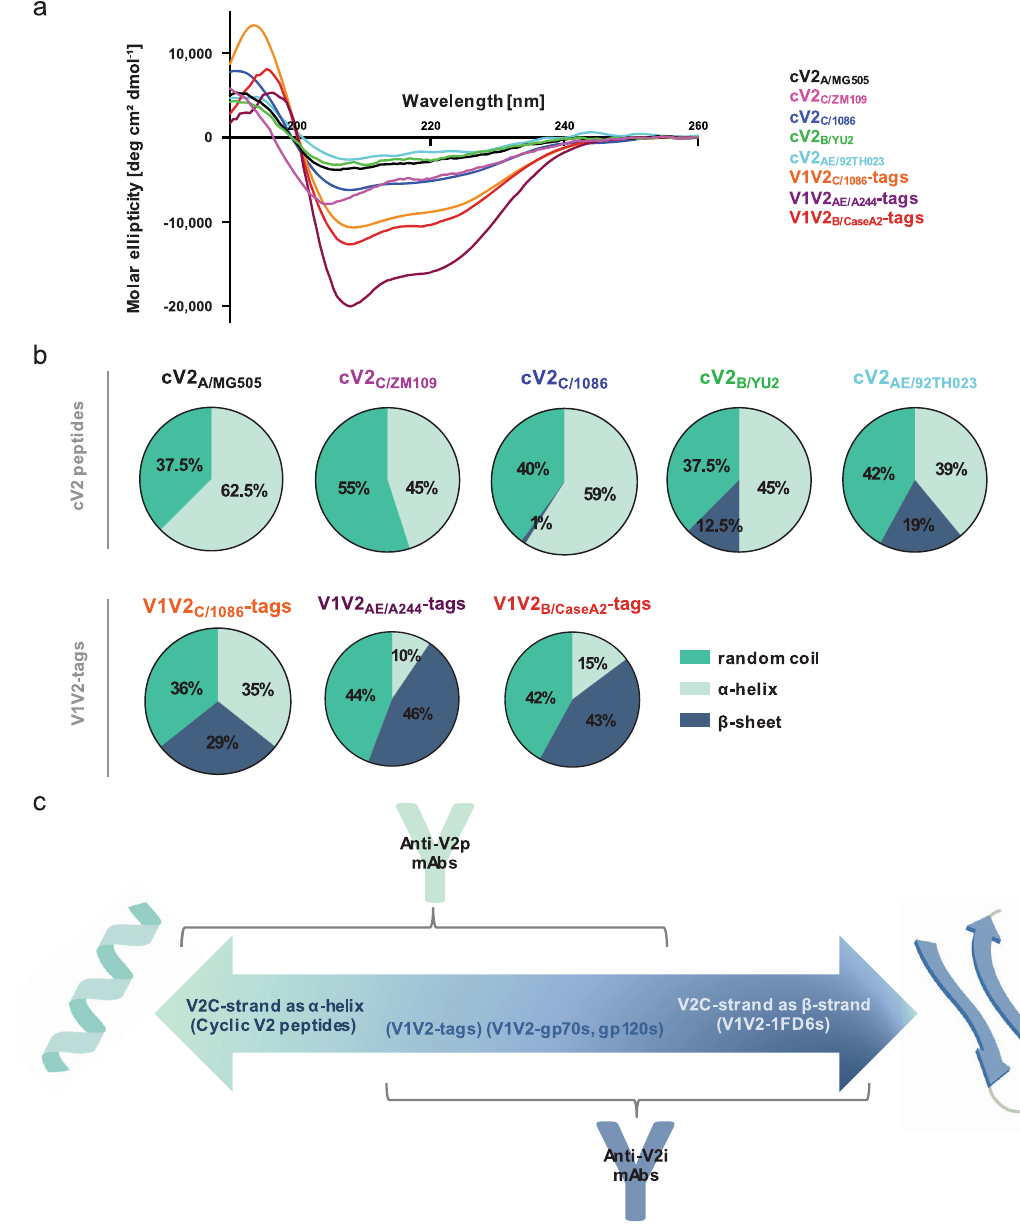
Fig. 2 Structural conformations of the V1V2 domain. a Circular dichroism spectra of fi ve cyclic V2 peptides and three V1V2-tags proteins. b Pie charts depicting the percentage of secondary structure (random coil [turquoise], α -helix [light green], or β -sheet [dark blue]) determined by the circular dichroism spectra and calculated by CD-FIT software (https://www.ruppweb.org/Xray/comp/cd fi t.htm). c Schematic diagram created with BioRender.com showing the alterative structures of the V2 C-strand (V2C) between an α -helix (left) and a β -strand (right). According to the proportion of each molecule present in the two conformations, the antigens will react preferentially with V2p Abs (left), V2i Abs (right), or both (middle). Abbreviations as in Fig.